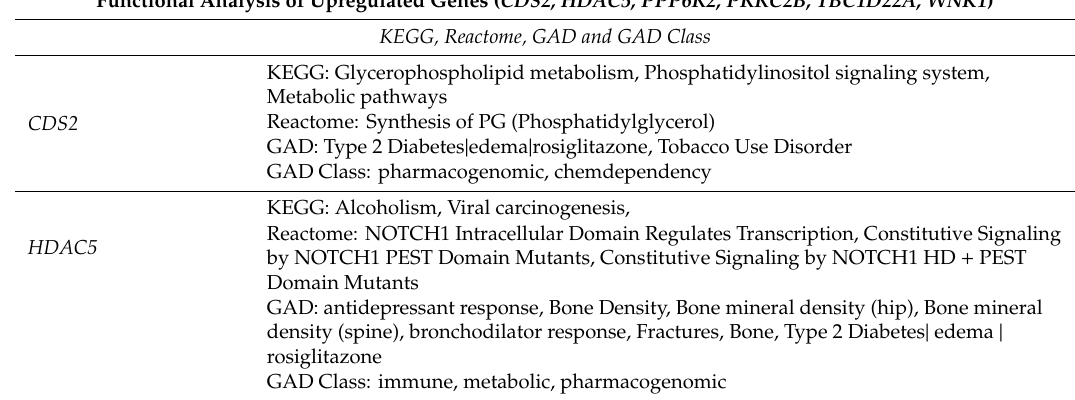
Table 4. Results of functional analysis of seven genes selected in silico as targets of miRNA identified as signatures of chronic venous